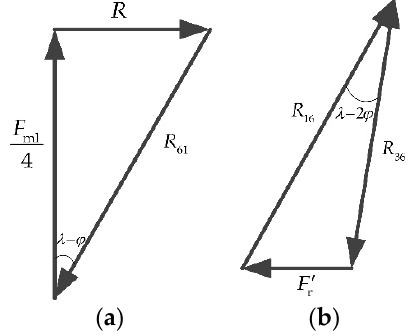
Figure 4. The force diagram of ( a ) the spring support cylinder and ( b ) the single locking tab.